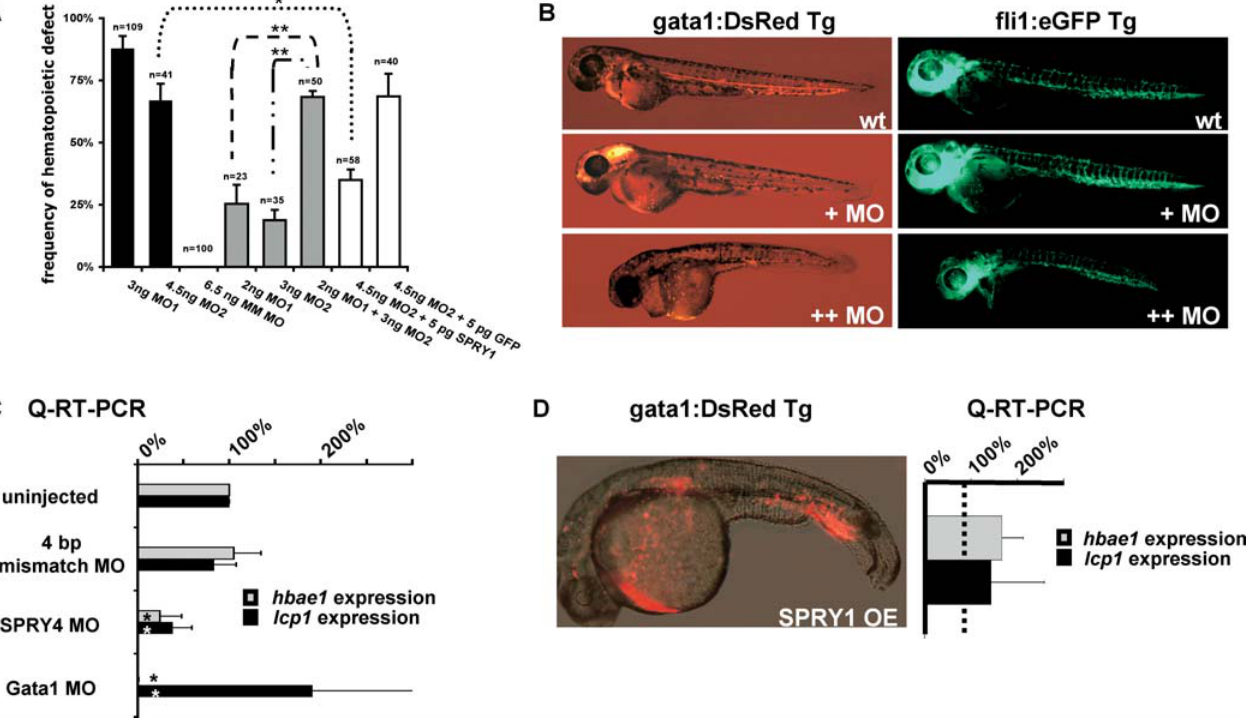
Figure 4. spry4 Is Required for Normal Hematopoietic Development in Zebrafish Embryos (A) The observed frequency of hematopoietic defects in gata1: DsRed Tg zebrafish embryos are indicated for two independent spry4 -targeted MOs (MO1 and MO2; black bars), a four-base mismatched control MO (MM MO; no bar indicates a 0% frequency), a low-dose injection of MO1 and MO2 individually and in combination (gray bars), and MO2 coinjected with a human SPRY1 DNA expression vector or a GFP control (white bars) (error bars ¼ standard deviation of the mean, * p , 0.05, ** p (cid:2) 0.01). (B) Representative pictures of the phenotypes seen with spry4 MO1 at 48 h using fli1: EGFP/ gata1: DsRed double Tg zebrafish embryos that have EGFP þ vascular endothelial cells and DsRed þ erythroid cells. The embryos display a more drastic reduction in DsRed þ blood cells with some blood pooling and pericardial edema at higher MO doses ( þþ MO) without major vasculature defects. The gata1: DsRed and fli1: EGFP Tg images are representative of three experiments of n . 40 embryos each. (C) Q-RT-PCR analysis of hbae1 and lcp1 transcripts in spry4 MO1, control mismatch MO and a gata1 MO-injected zebrafish at 48 hpf (* p , 0.05). (D) Injection of 30 pg of human SPRY1 DNA expression vector resulted in an expansion of DsRed þ hematopoietic cells in the posterior ICM in greater than 50% of successfully injected embryos at 32 hpf (three experiments of n ¼ 30), and a representative bright-field image is pictured with the fluorescence micrograph overlaid (left). Q-RT-PCR analysis of hbae1 and lcp1 transcripts in SPRY1 overexpressing embryos relative to uninjected clutchmate controls (three experiments of n ¼ 5 embryos) (right). DOI: